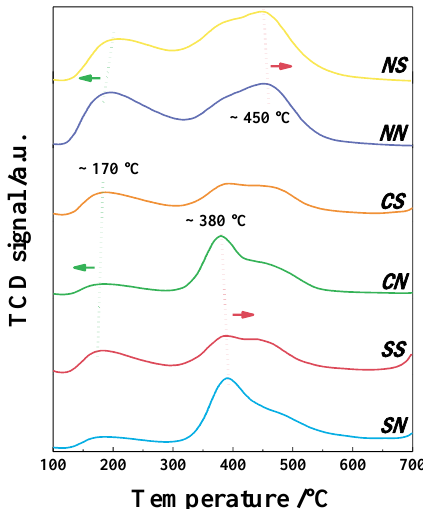
Figure 9. NH 3 -TPD profiles over titanium modified FeMgO x catalysts with different precursors.